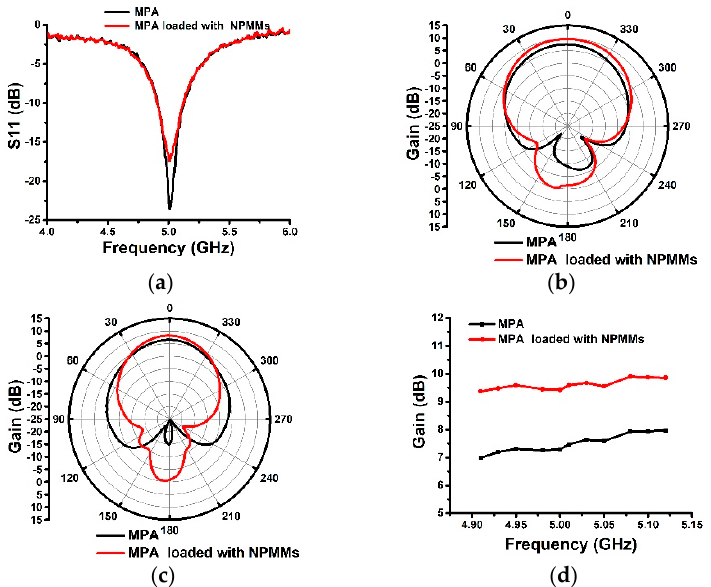
Figure 6. Measured parameters of the two antennas ( a ) return loss S11; ( b ) gain in the E-plane; ( c ) gain in the H-plane gain; ( d ) gains versus frequency. The gain of the two antennas is measured in the microwave anechoic chamber at 5.01 GHz. The radiation patterns of two antennas are shown in Figure 6b,c. The gain is changed from 7.47 to 9.58 dB with an increment of 2.12